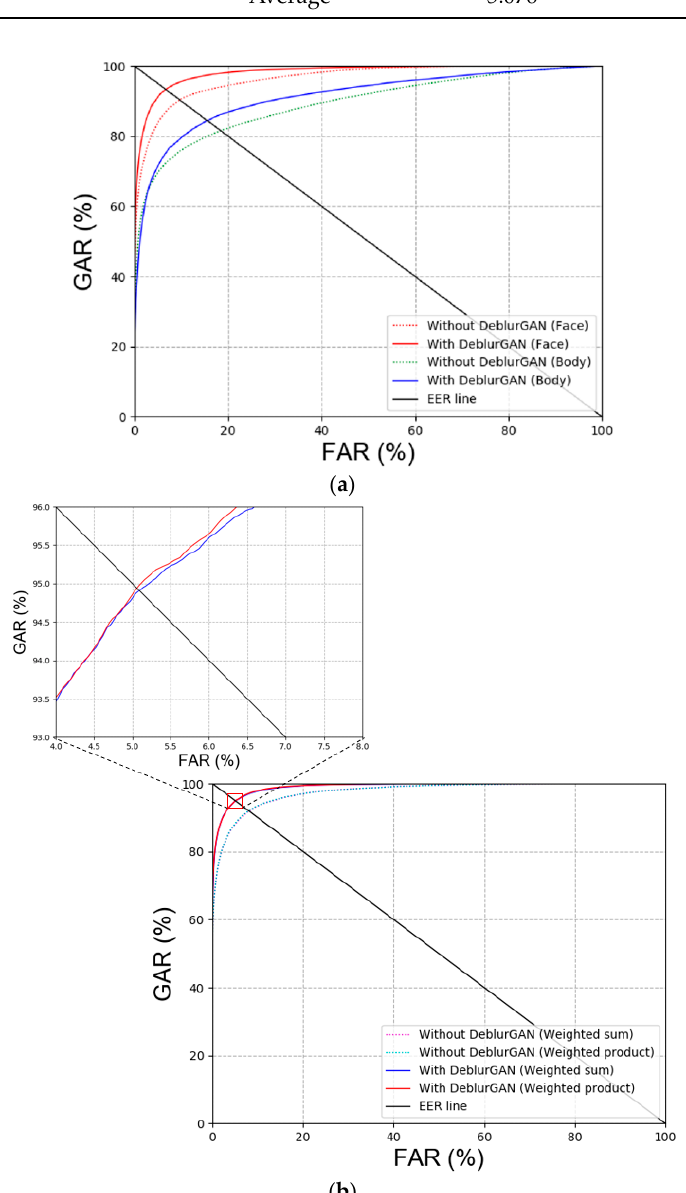
Figure 14. ROC curves with and without DeblurGAN performance on ChokePoint dataset. ( a ) Face and body image recognition results and ( b ) score-level fusion result.